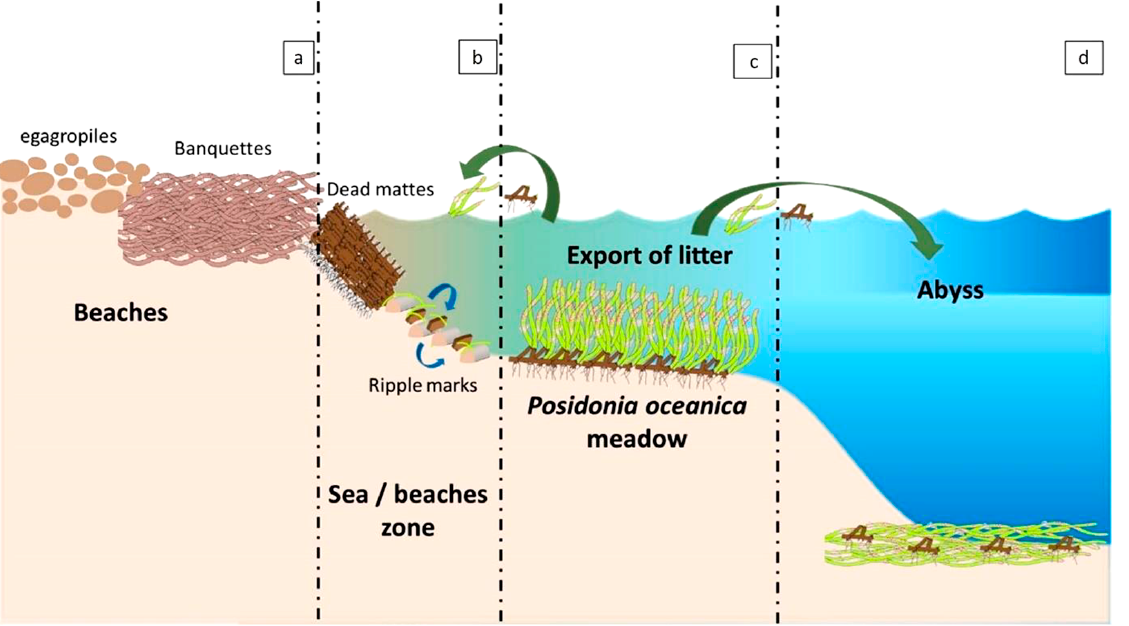
Figure 1. Meadow of Posidonia oceanica organs: ( a ) beaches with Egagropiles and banquettes; ( b ) beach zone with dead mattes and meadow organs in ripple marks; ( c ) Posidonia oceanica meadow with its coastline being exported to the abyss; and ( d ) the abyss with clusters of various organs of the meadow [7].